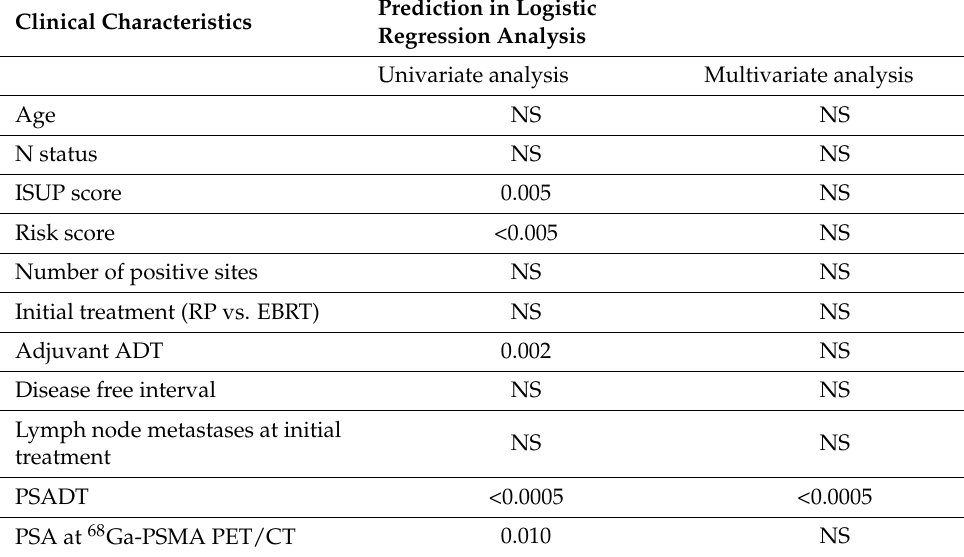
Table 2. Clinical characteristics and association with positive 68 Ga-PSMA PET/CT scans ( n = 95).